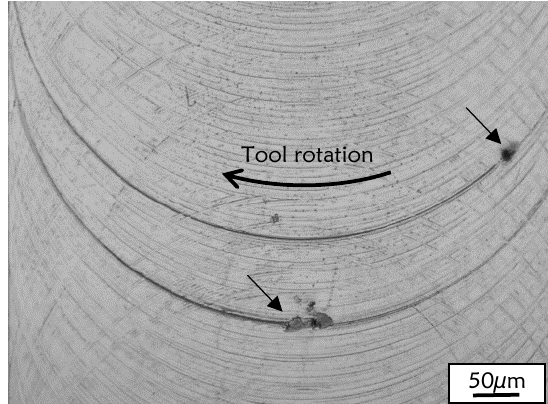
Figure 23. Material defects that affect machining of SLM IN718: (1) unmelted powder at surface, (2) brittle Laves phase, and (3) burr covered pore [39].